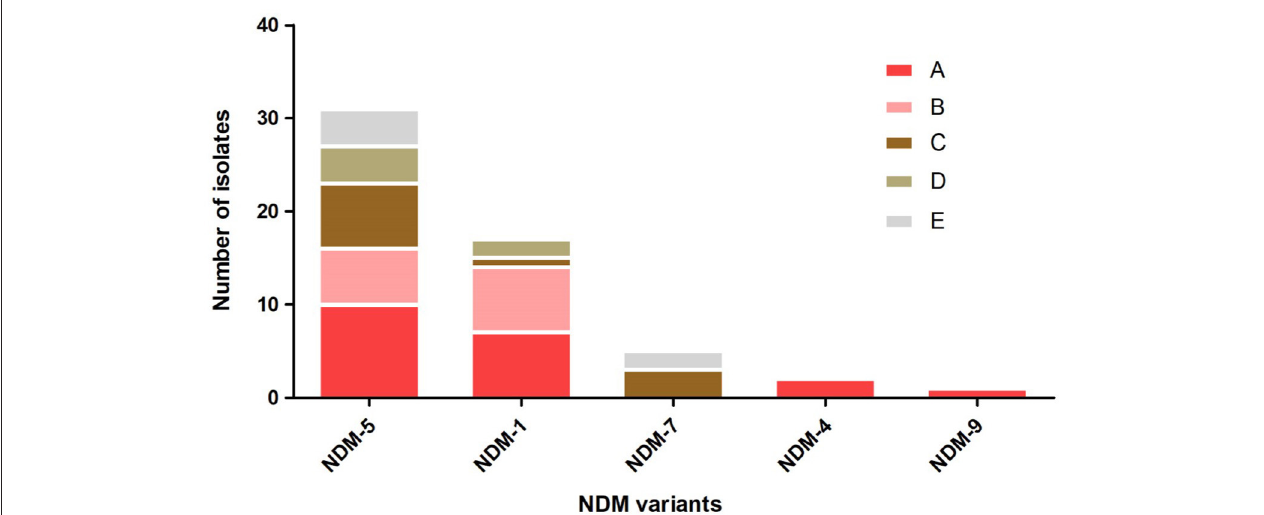
FIGURE 1 | The distribution of bla NDM variants among different hospitals. Hospital A, the Affiliated Hospital of Xuzhou Medical University; Hospital B, the Children’s Hospital of Xuzhou; Hospital C, the People’s Hospital of Suqian; Hospital D, the First People’s Hospital of Suqian; Hospital E, the Second People’s Hospital of Lianyungang.